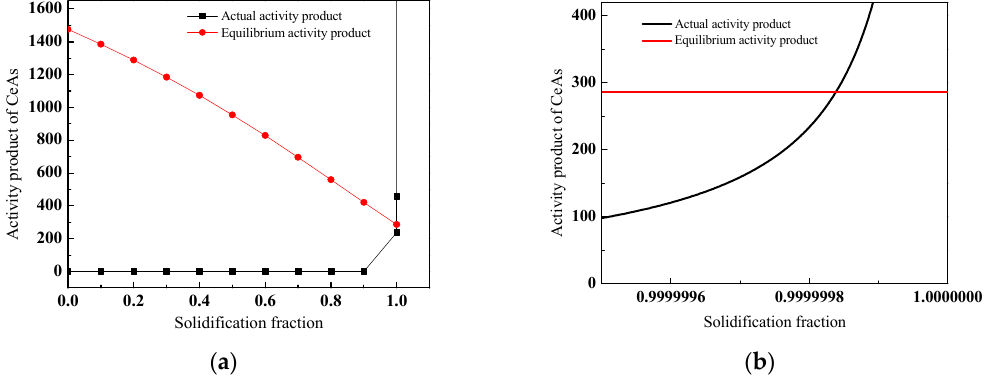
Figure 11. The actual activity product and equilibrium activity product of CeAs. ( a ) Whole solidification process; ( b ) the solidification end.